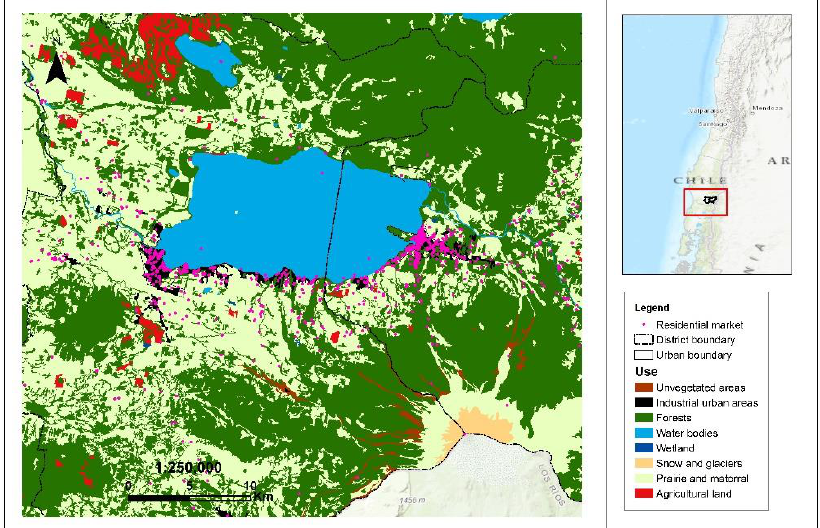
Figure 11. Classification of land use and cover in Villarrica and Pucón. Source: compiled by the authors using LANDSAT 8 TM images.